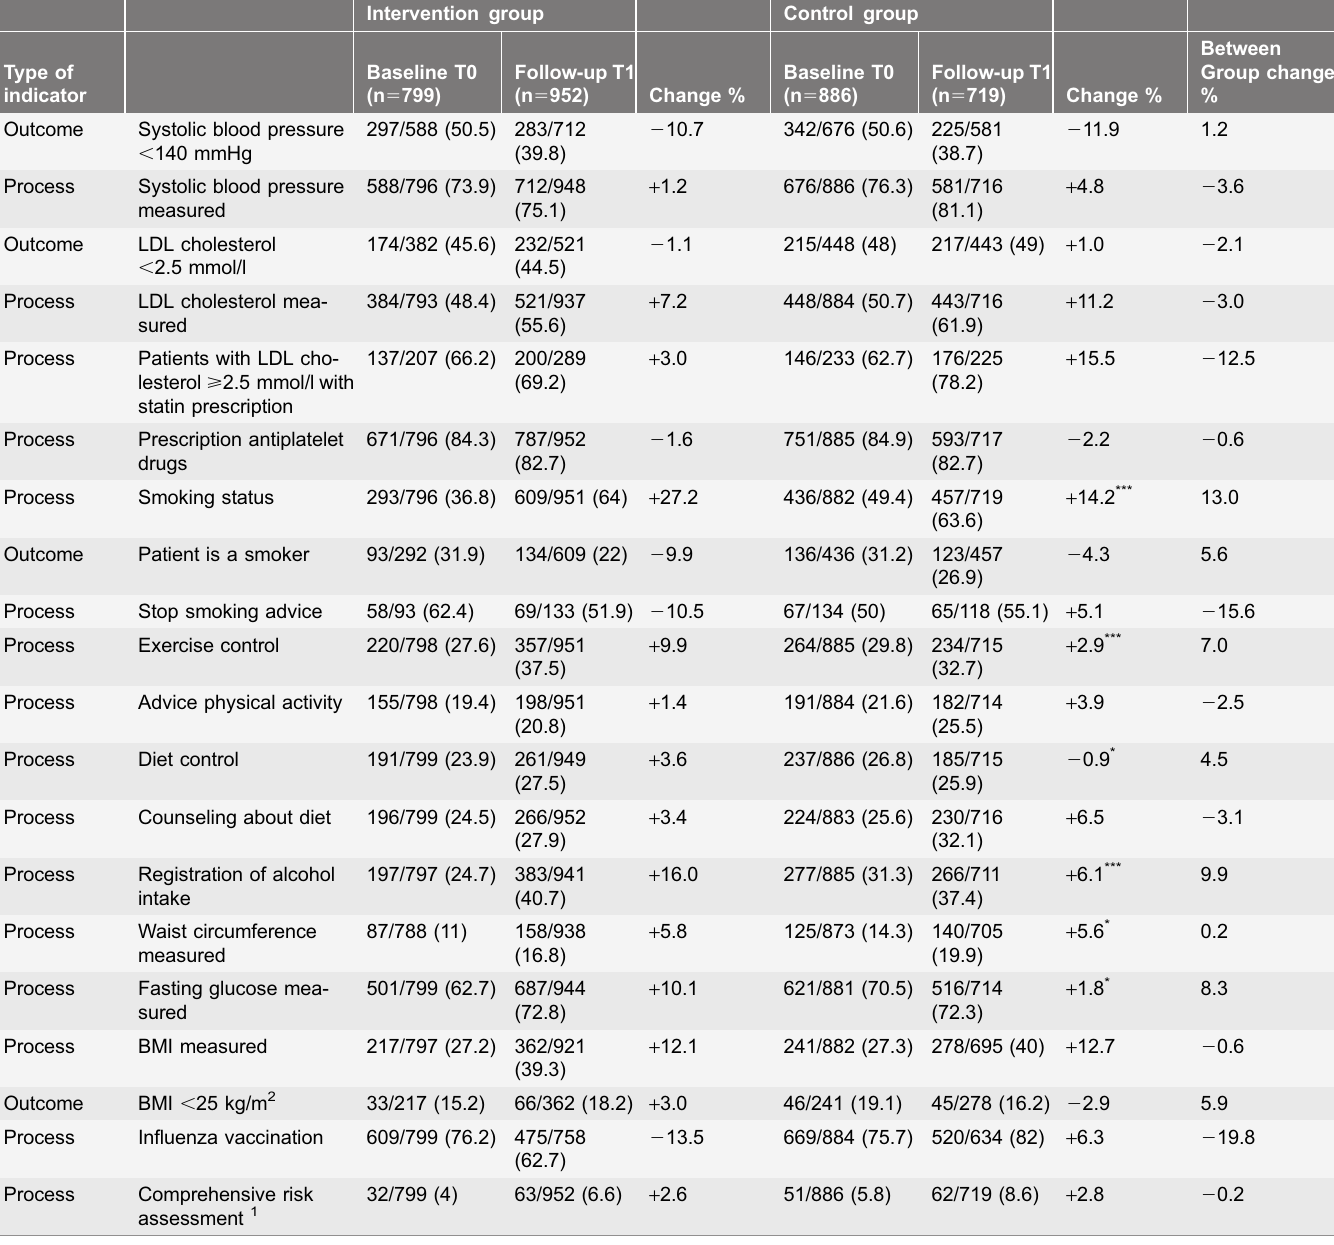
Table 3. Record of indicators for cardiovascular risk management in electronic medical